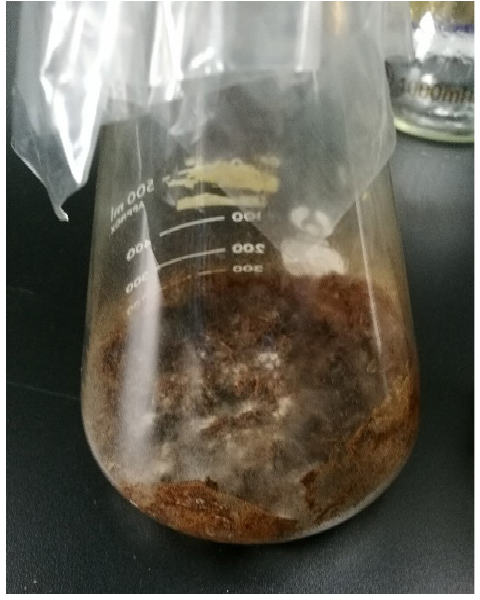
Figure 3: On day 9 during the fermentation of Phanerochaete chrysosporium on the Magnolia officinalis residues.